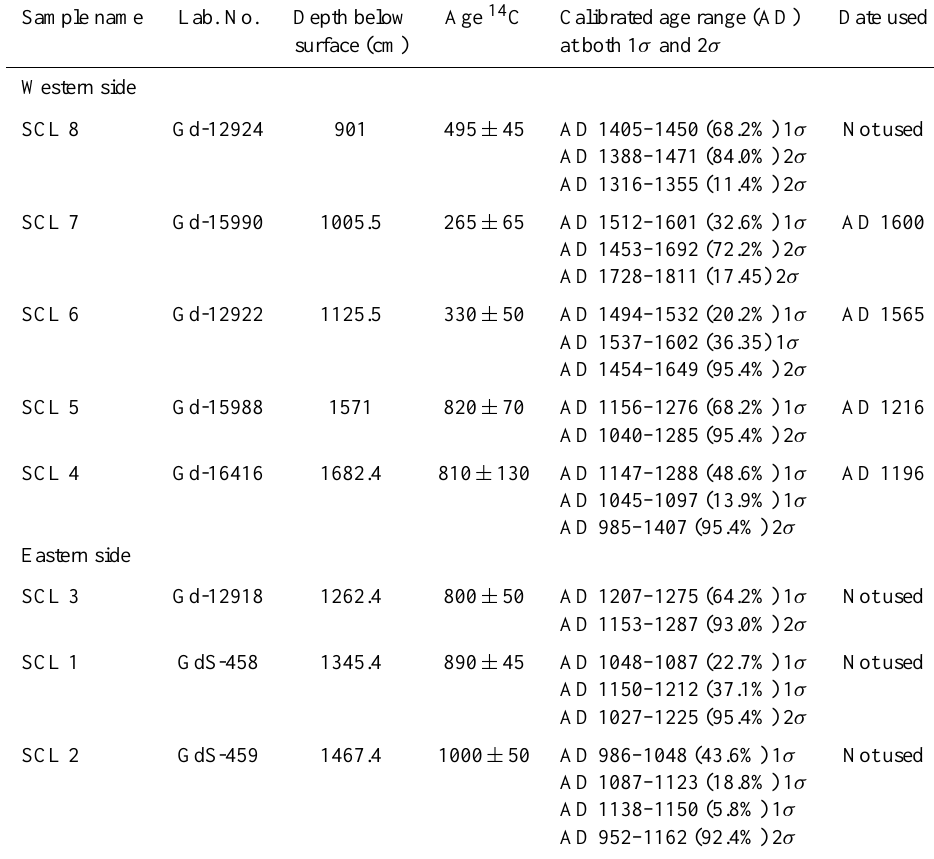
Table 1. Results of the radiocarbon analysis of samples collected from Sc˘aris¸oara Ice